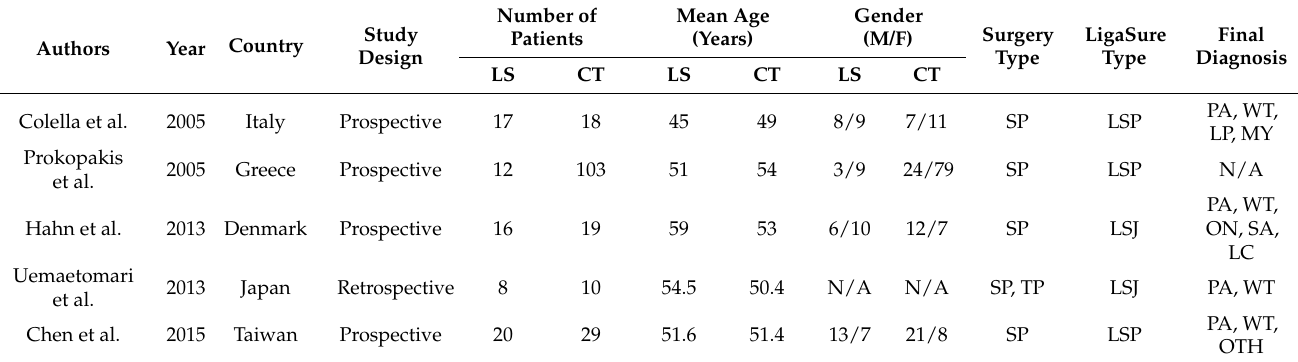
Table 1. Characteristics of the included studies.